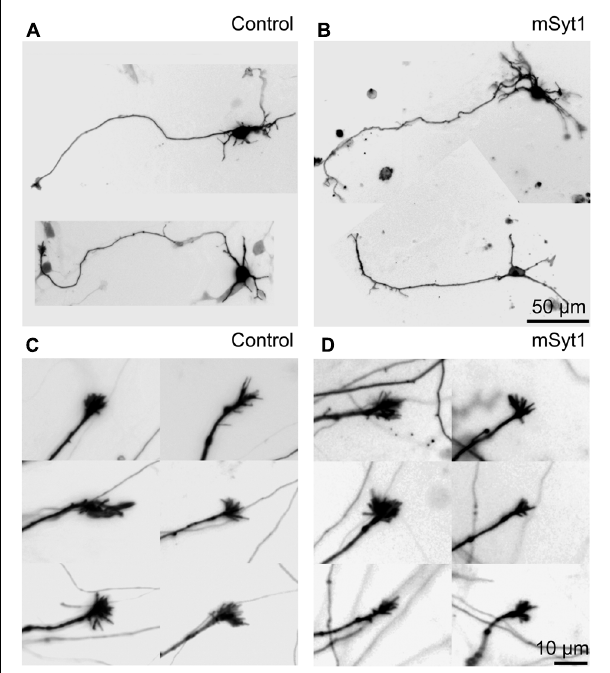
FIGURE 6 |Axon growth is normal in thalamic neurons expressing mutant synaptotagmin . (A) Representative fluorescence micrographs of thalamic dissociated neurons in culture.The LUTs are inverted for clarity. (B) Representative neurons expressing mSyt1. (C) Representative fluorescence micrographs of axonal growth-cones of thalamic neurons in culture. (D) The growth cones in the axons of thalamic neurons expressing mSyt1 show a normal